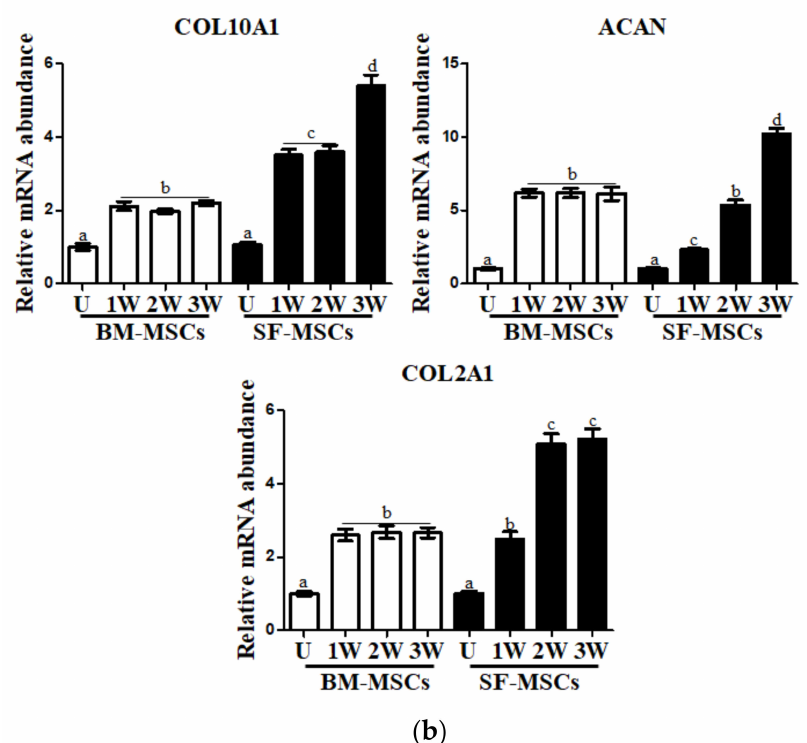
Figure 5. In vitro chondrocyte differentiation capacity by time of BM- and SF-MSCs. Chondrogenesis was evaluated by cytochemical staining and RT-qPCR analysis. ( a ) In vitro chondrocyte differentiation was demonstrated by Alcian blue staining in induced pellets one, two, and three weeks after induction. Scale bar = 500 µ m. ( b ) Genes (COL10A1, ACAN, and COL2A1) expressed in chondrocytes, in induced BM- and SF-MSCs one, two, and three weeks after induction. At three weeks following chondrogenesis, all chondrocyte-specific markers were significantly increased in chondrocyte pellets in SF- versus BM-MSCs. Values displayed as mean and ± SD, independent experiments ( n = 4). Different superscripts (a, b, c, and d) denote significant differences ( p < 0.05) among undifferentiated cells, and 1, 2, and 3 weeks of differentiated cells using BM-MSCs and SF-MSCs (white bar: undifferentiated cells; black bar: differentiated cells U: undifferentiated cells; 1W: one week after chondrocyte induction; 2W: two weeks after chondrocyte induction; 3W: three weeks after chondrocyte induction).